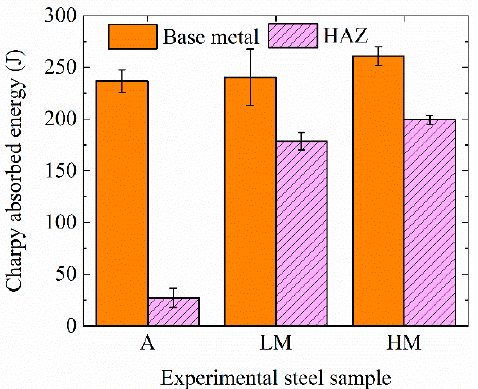
Figure 3. Impact toughness of base metals at − 40 °C and HAZs at − 20 °C of experimental steel samples.